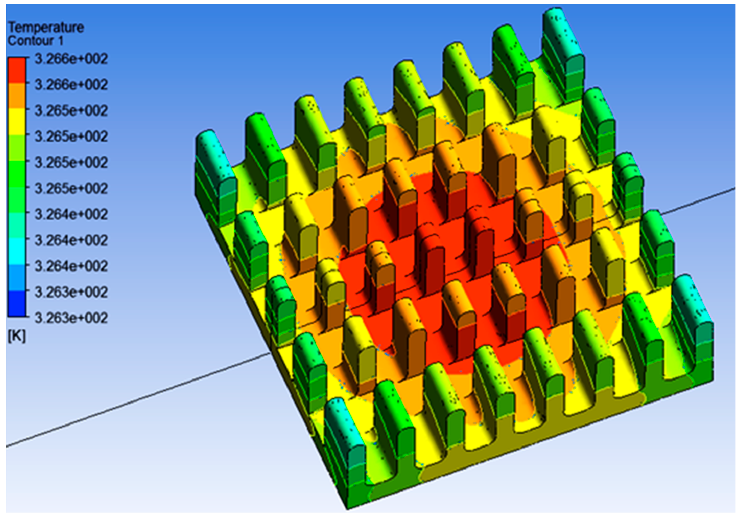
Figure 7. Temperature distribution through the heat sink.